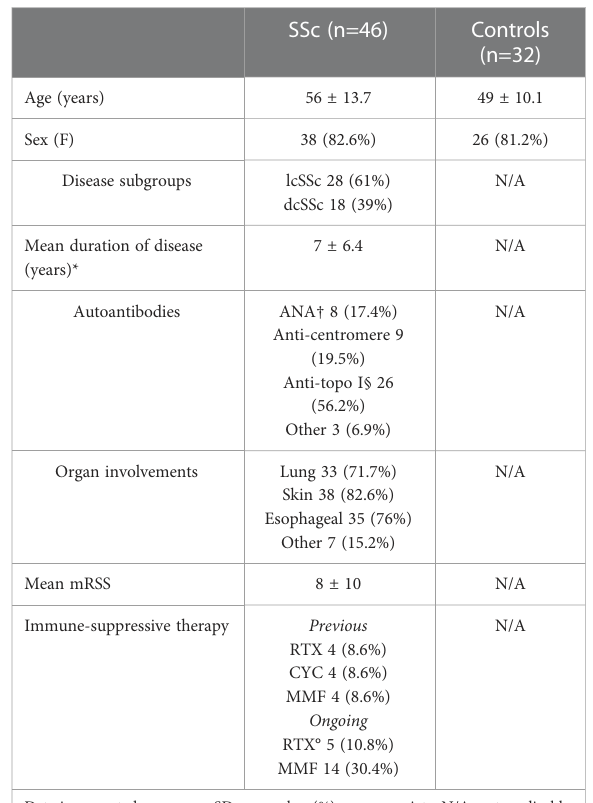
TABLE 1 Demographic characteristics of SSc patients and